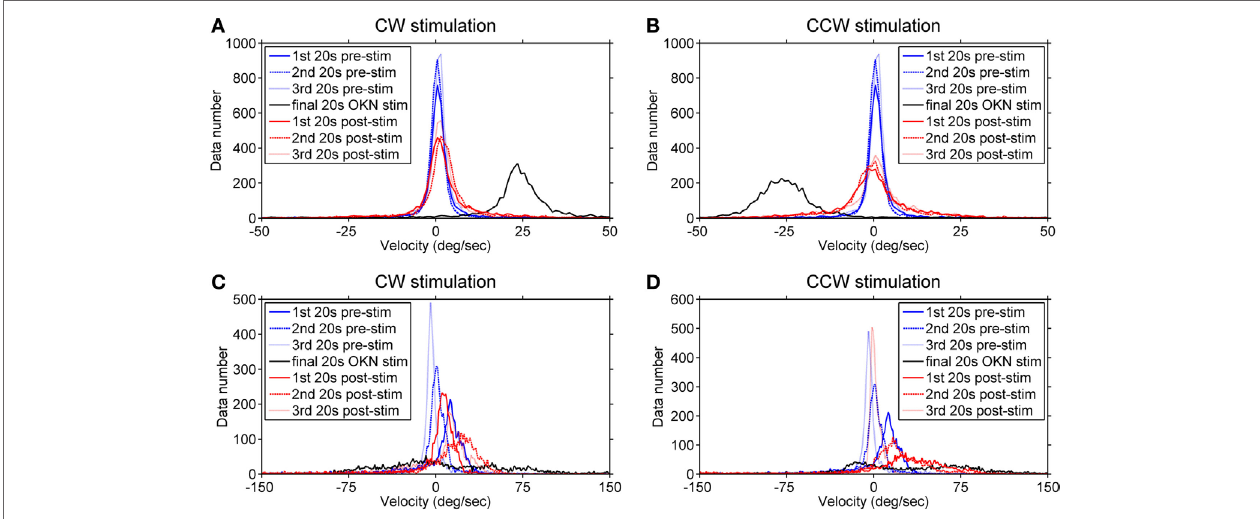
FigUre 5 | Velocity distribution before, during, and after the optokinetic stimulation. The data numbers within each time window of 20 s were plotted against velocity ranks (every 1°/s). Plots on the top demonstrate the velocity distribution of the healthy subject (a,B) and, at the bottom, of the infantile nystagmus syndrome (INS) patient (C,d) . The velocity distributions during the pre-stimulation phase are shown in (a,B) of the healthy subject and (C,d) of the INS patient. Plots on the left demonstrate the velocity distribution during and after the clockwise (positive) stimulation while the plots on the right demonstrate the velocity distribution during and after the counterclockwise (negative) stimulation. The velocity distributions during the pre-stimulation phase are shown as blue line (first 20 s), blue dashed line (second 20 s), and blue dotted line (third 20 s); during the final 20-s stimulation phase as black line; during the post-stimulation phases as red line (first 20 s), red dashed line (second 20 s), and red dotted line (third 20 s). 1st 20 s pre-stim = first 20 s of the pre-stimulation phase; 2nd 20 s pre-stim = second 20 s of the pre-stimulation phase; 3rd 20 s pre-stim = third 20 s of the pre-stimulation phase; final 20 s optokinetic nystagmus (OKN) stim = final 20 s of the optokinetic stimulation phase; 1st 20 s post-stim = first 20 s of the post-stimulation phase; 2nd 20 s post-stim = second 20 s of the post-stimulation phase; 3rd 20 s post-stim = third 20 s of the post-stimulation